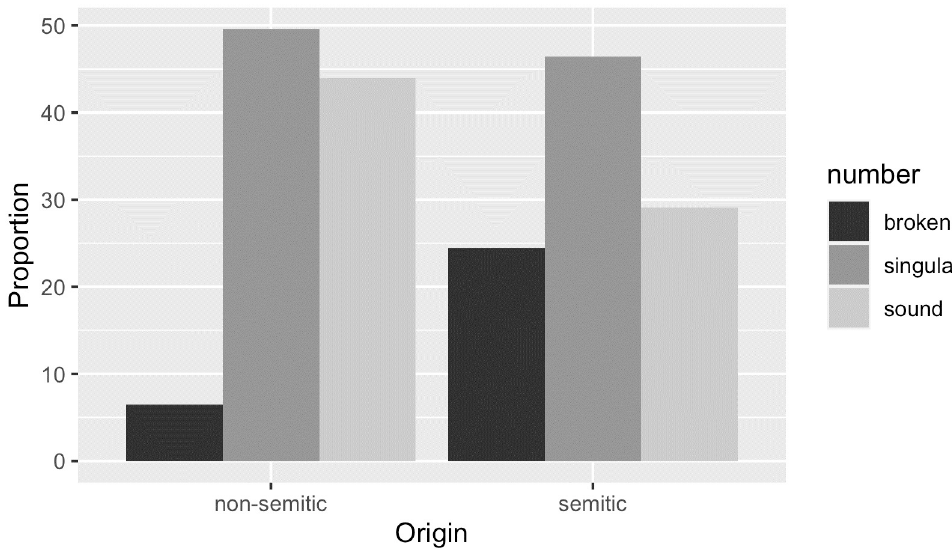
Fig 1. Proportion of singular, broken and sound plural nouns in the Maltese data set classified as Semitic vs. Non- Semitic.